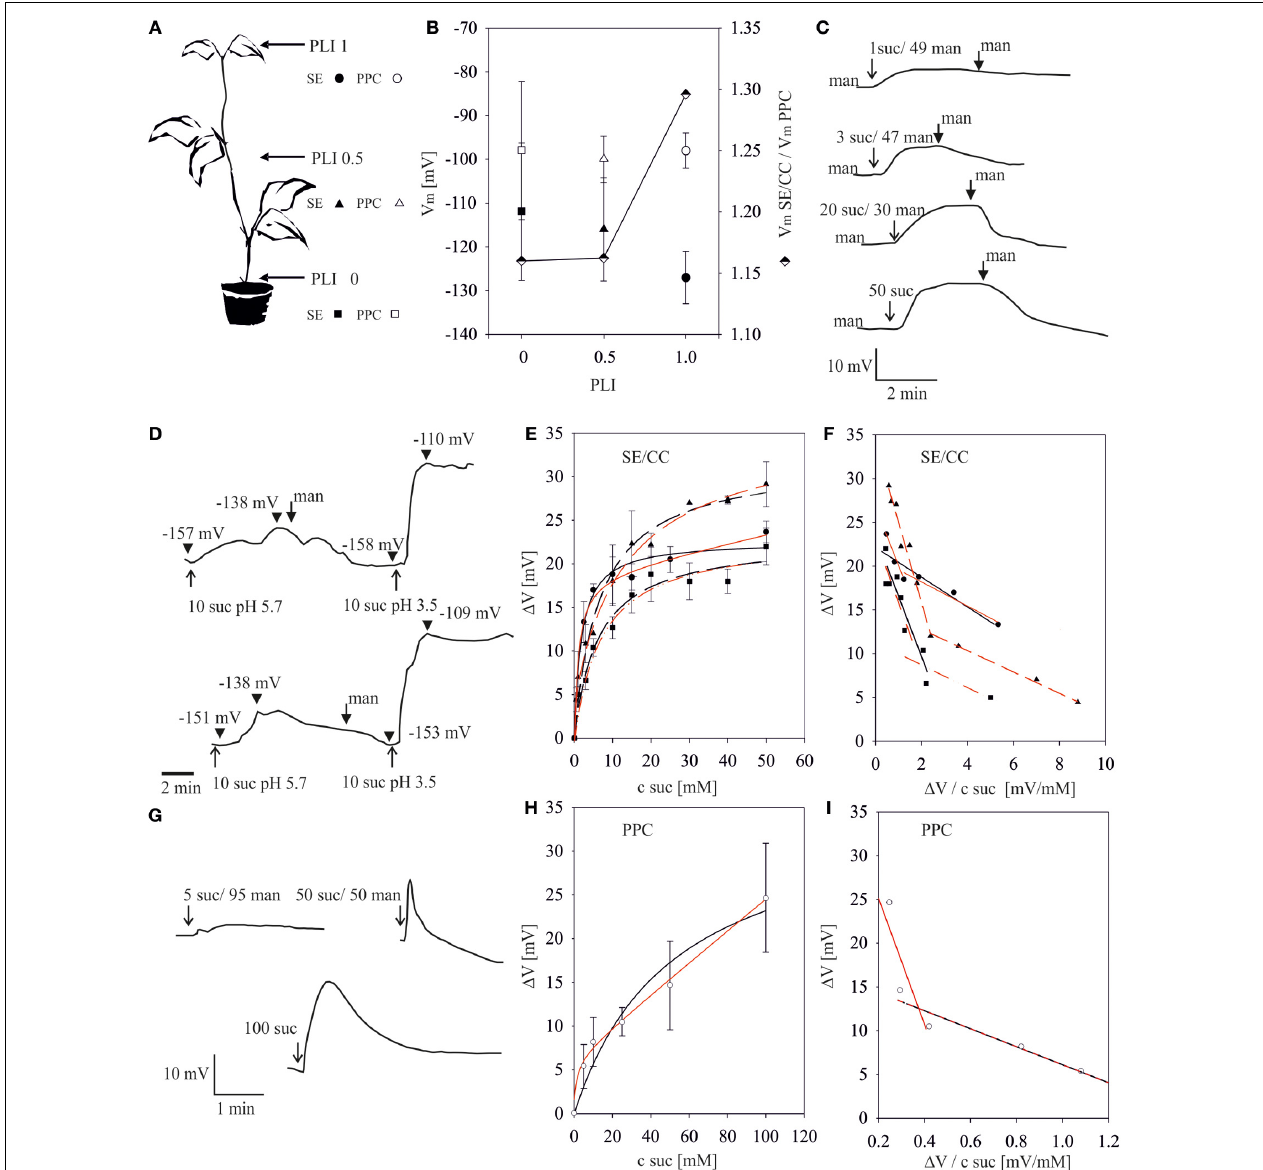
FIGURE 1 | Sucrose-induced depolarizations in sieve-elements (SEs) and phloem parenchyma cells (PPCs) along the stem of intact Vicia faba plants. (A) Plant length indices (PLIs: 1.0, mid-vein of the youngest mature leaf; 0.5, half-way the stem; 0, stem-to-root transition area) standardize the microelectrode positions along plants of diverse lengths. The symbols (circles, triangles, squares) associated with certain PLIs are used in the following figures. The numbers associated with sucrose (suc) and mannitol (man) in the following figures represent their concentrations (mM). (B) Membrane potential resting levels ( V m , ± SD, left y -axis) in SE/CCs and PPCs along the plant axis. Membrane potential ratios ( V mSE / CC / V mPPC , semi-filled diamonds, right y -axis) along the phloem pathway. (C) Typical recorder traces showing the time-course of the change in SE membrane potentials at PLI 1.0 in response to the addition of 1, 3, 20 and 50mM sucrose, respectively. The start of perfusion with test solutions is marked by arrows, that of mannitol rinsing by fat arrows. (D) pH-dependence of sucrose uptake into single SEs. Depolarizations in response to 10mM sucrose pH 5.7 and 10mM sucrose pH 3.5 intermitted by rinsing with mannitol. The start of perfusion with test solutions is